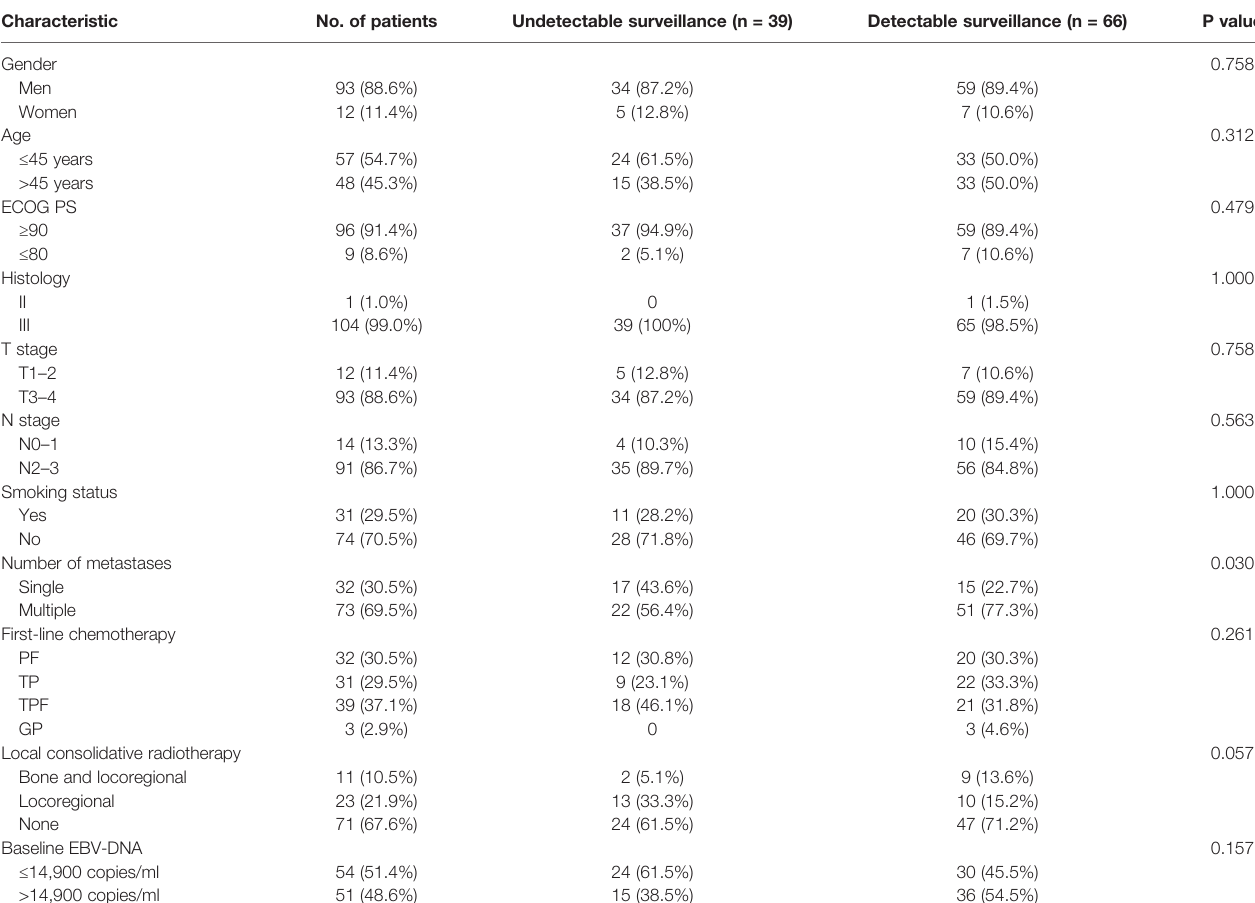
TABLE 1 | Patient characteristics.